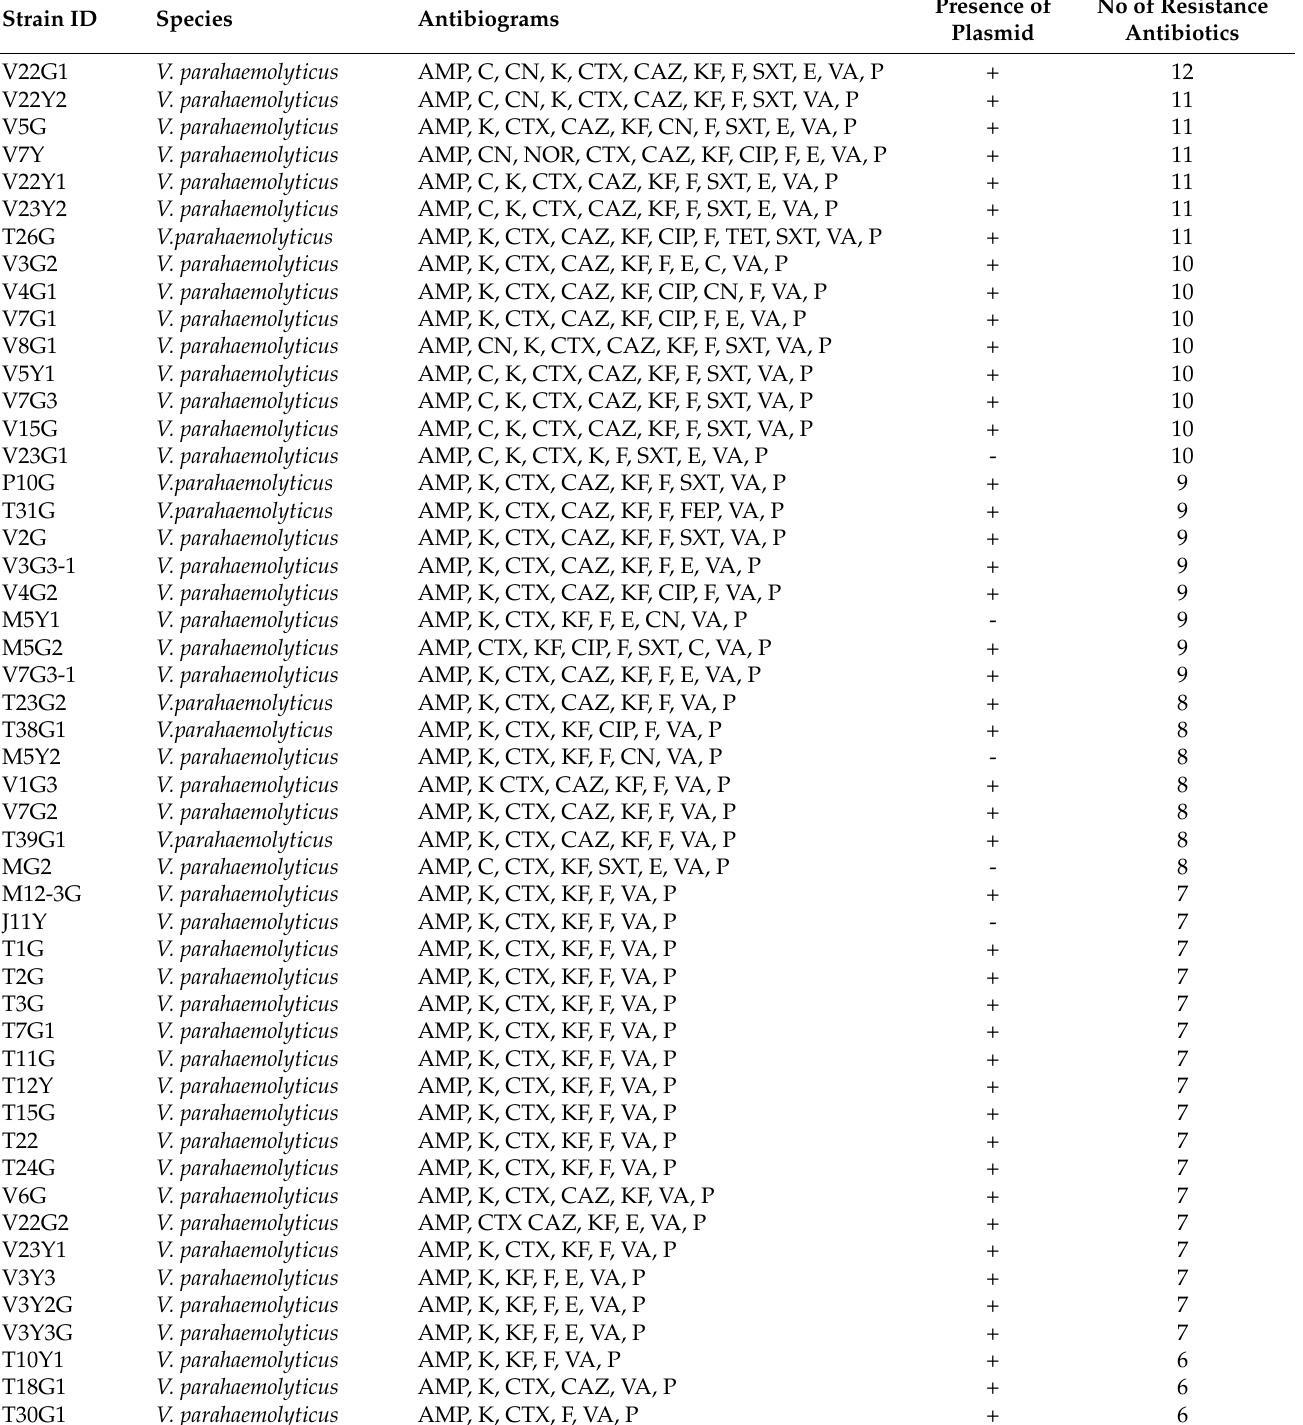
Table 6. Antibiograms and the presence of plasmid of different Vibrio